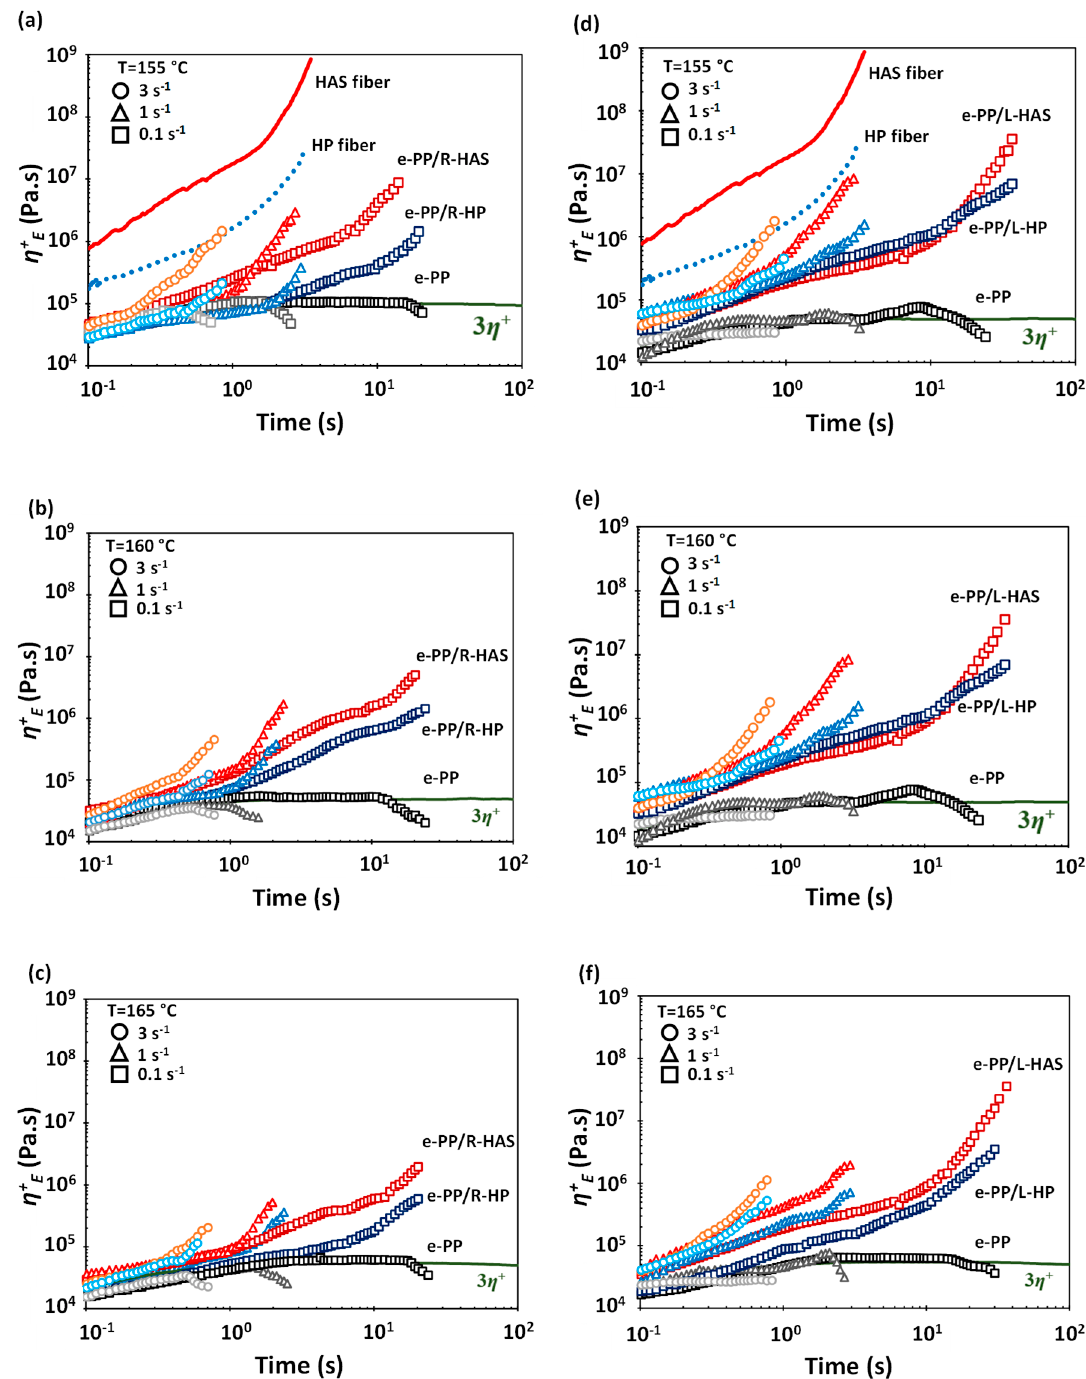
Figure 11. Tensile stress growth coefficient, η + E , of e-PP, HP microfibers, HAS microfibers, and composites of e-PP and microfibers at 155, 160, and 165 ◦ C and at Hencky strain rates and 3 s − 1 . The solid lines are 3 times the stress growth coefficient of steady simple shear at a strain rate of 0.05 s − 1 , which is in the linear regime; ( a – c ) have randomly distributed microfibers, and ( e – f ) have linearly aligned